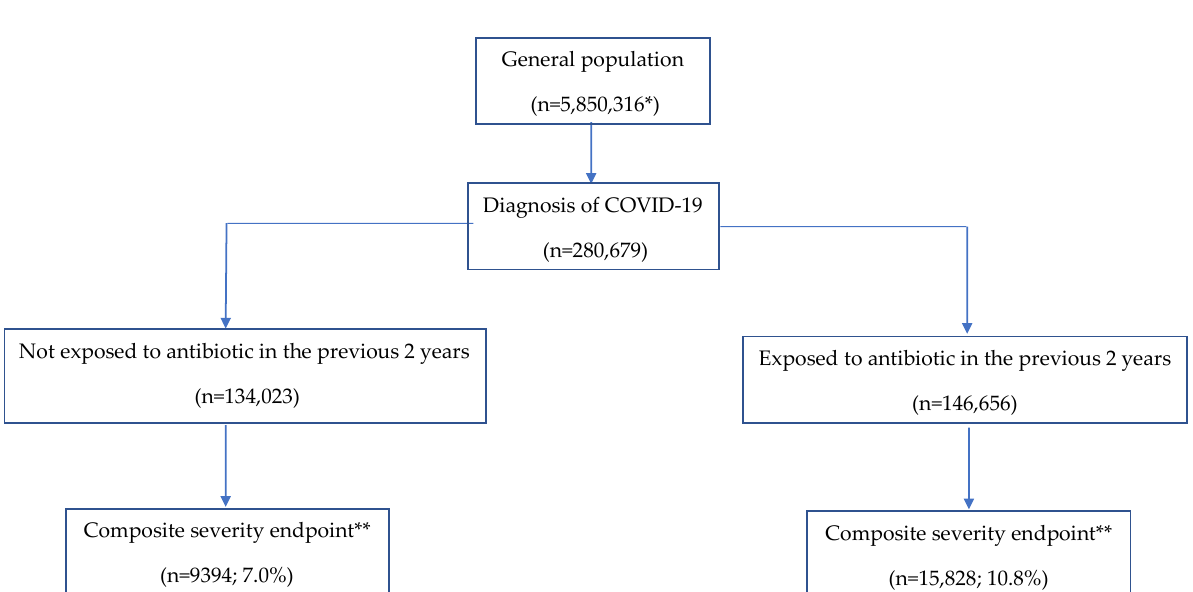
Figure 1. Flowchart of the study participants. * Up to 30 June 2020, ** Includes pneumonia, hospitalization and/or death due to COVID-19.